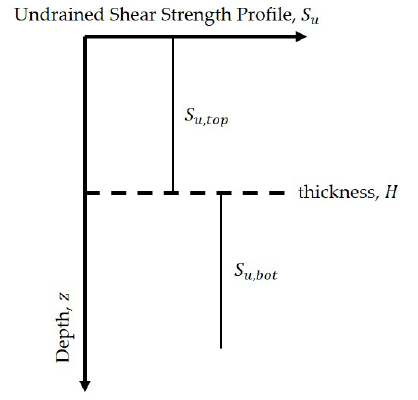
Figure 2. Two-layered cohesive soil strength profile.